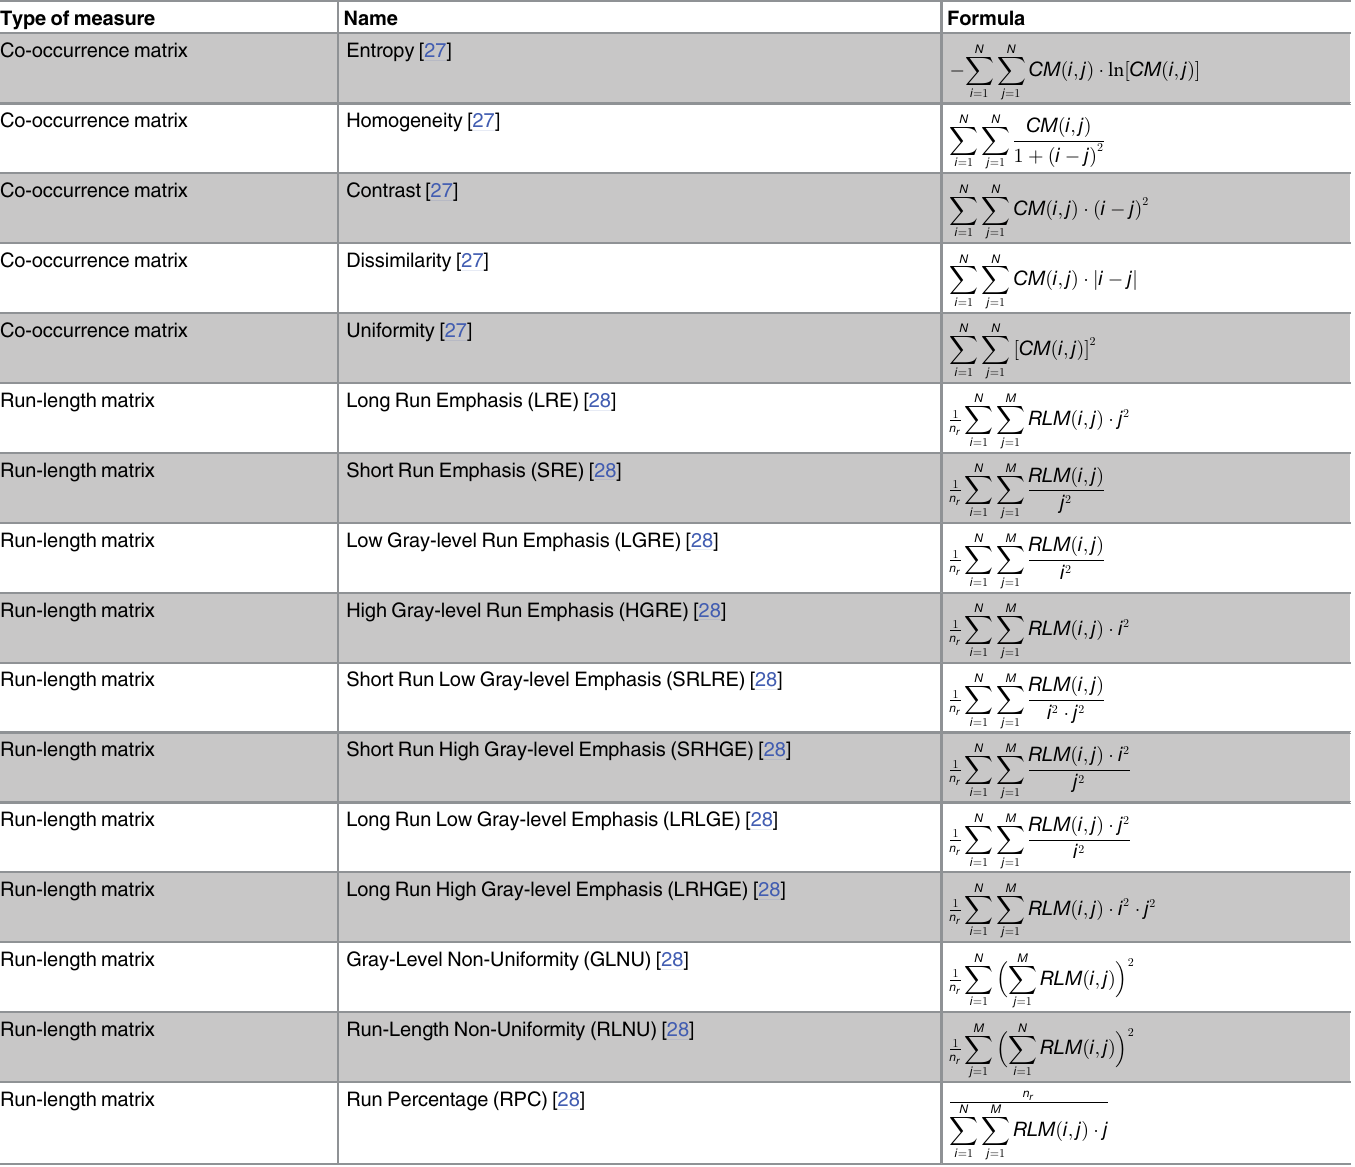
Table 3. Definition of the heterogeneity measures computed in this